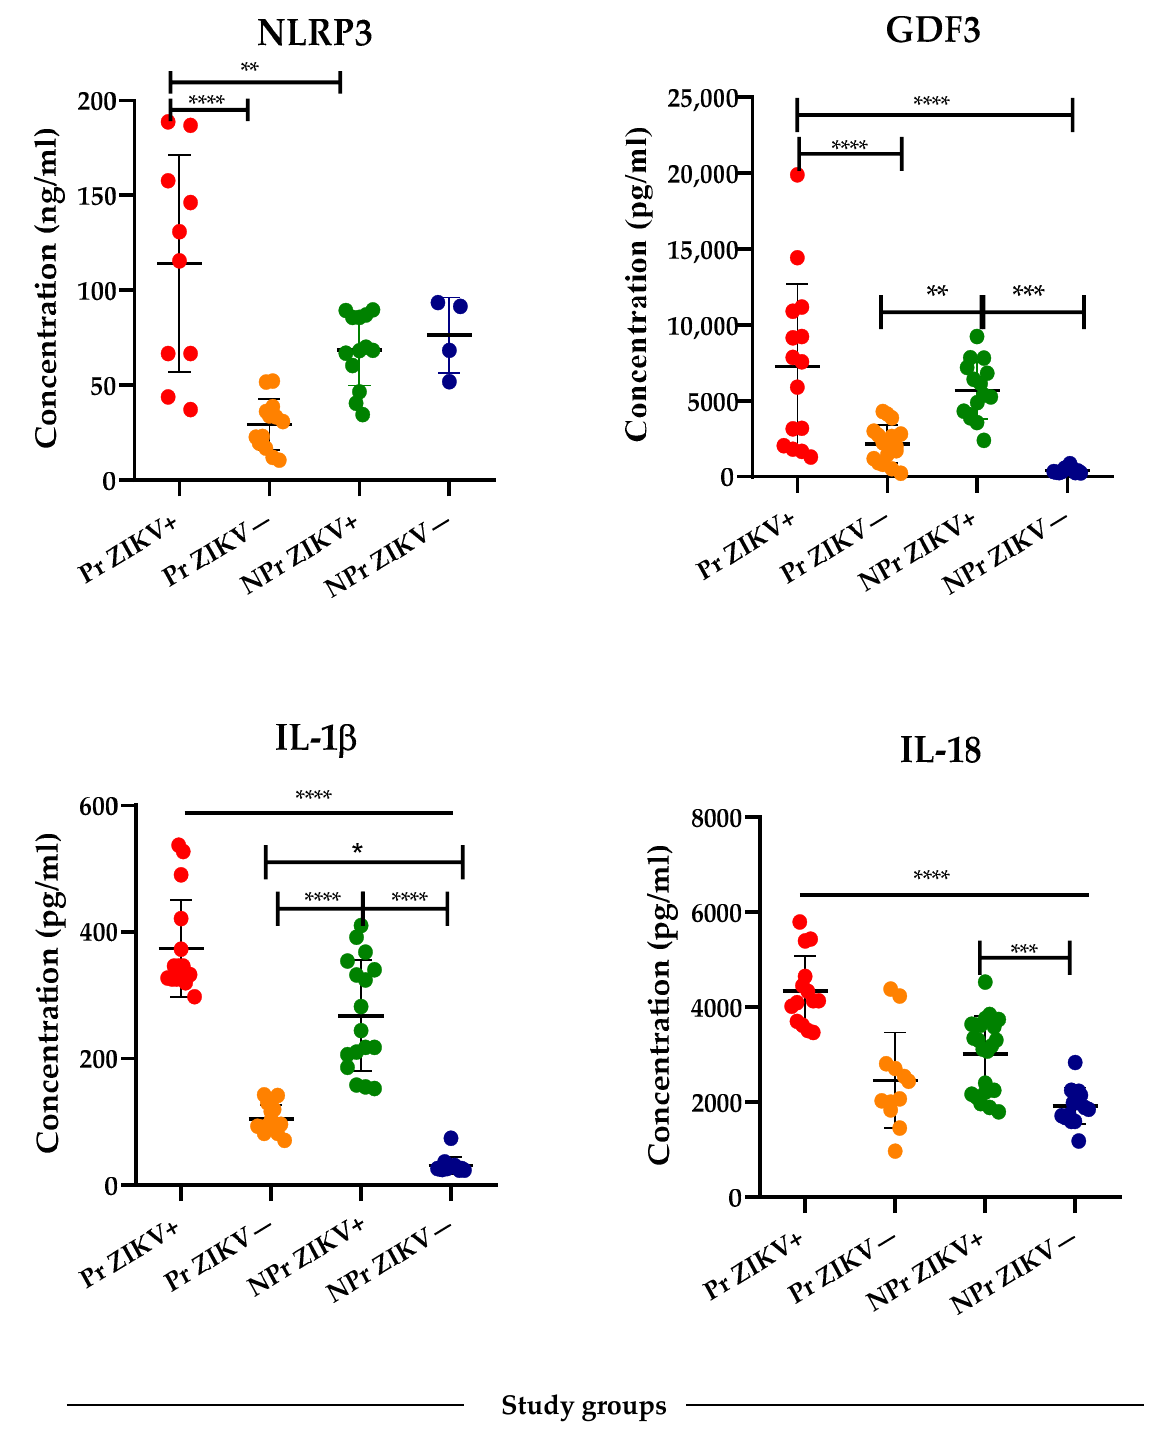
Figure 1. Serum levels of GDF3 and inflammasome-related markers. Analysis of serum marker levels performed in ZIKV-infected pregnant women (Pr ZIKV+), ZIKV-negative pregnant women (Pr ZIKV − ), ZIKV-infected non-pregnant women (NPr ZIKV+), ZIKV negative non-pregnant women (NPr ZIKV − ). One-Way ANOVA with Tukey’s multiple comparison test was performed in the statistical analysis. **** p < 0.0001, *** p < 0.001, ** p < 0.01 , * p < 0.05.